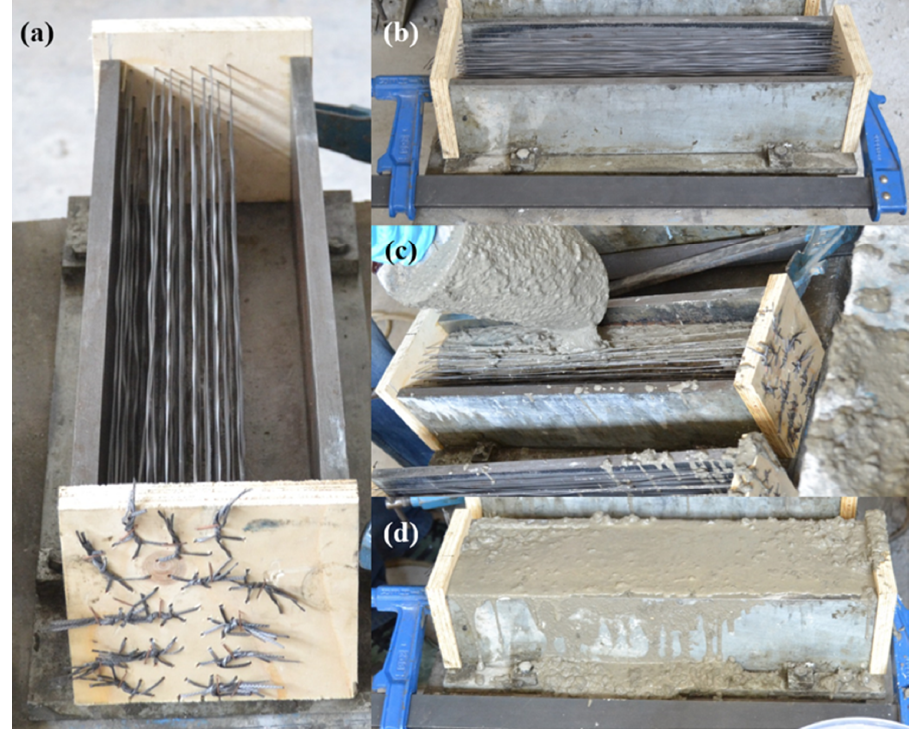
Figure 2. Cross-section of the specimens performed with a homogeneous distribution of fibers.